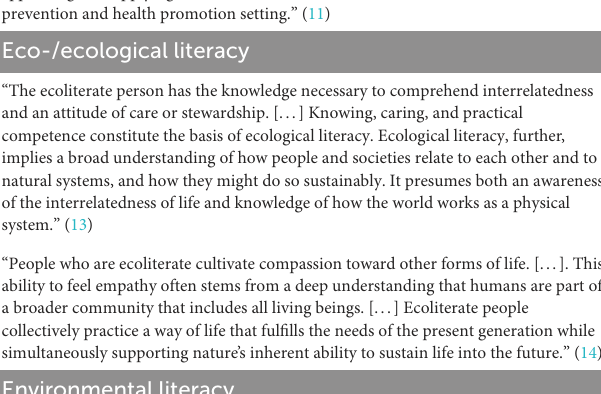
TABLE 1 Definitions of selected literacy concepts of relevance for planetary